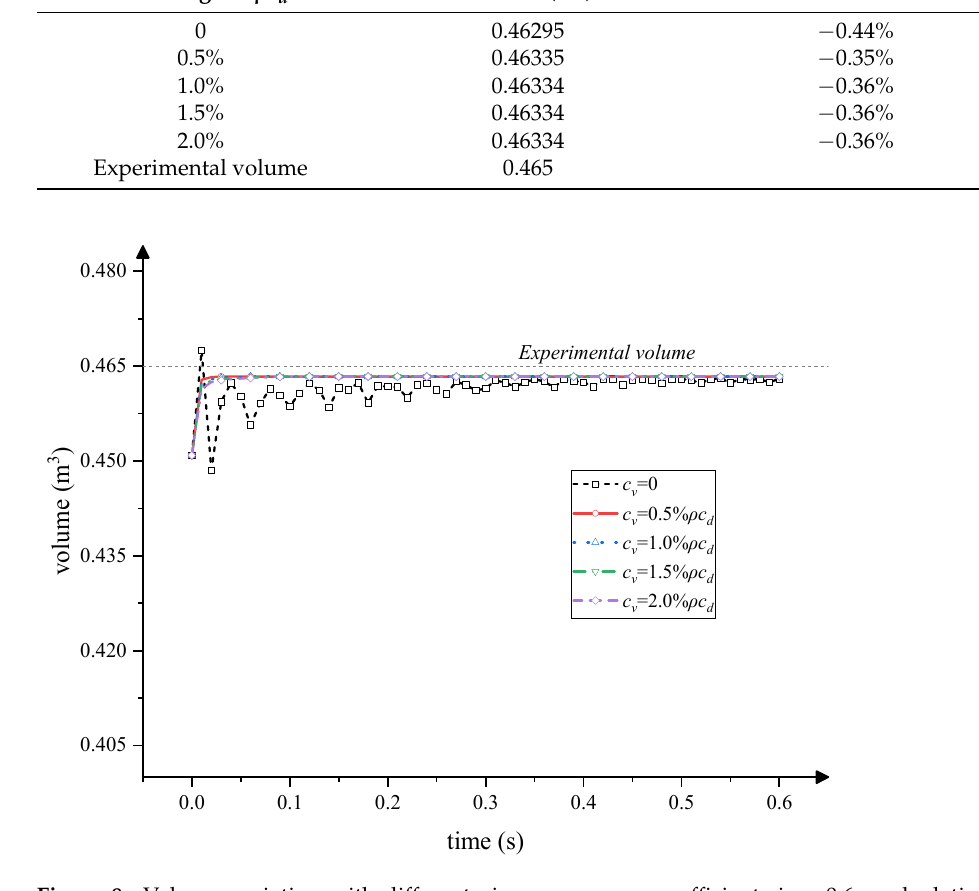
Figure 8. Volume variation with di ff erent viscous pressure coe ffi cients in a 0.6 s calculation of stabilization at the full state. Table 3. Volume results for fi ve di ff erent percentages of ρ c d for viscous pressure coe ffi cient and errors with respect to the experimental volume of 0.465 m 3 .